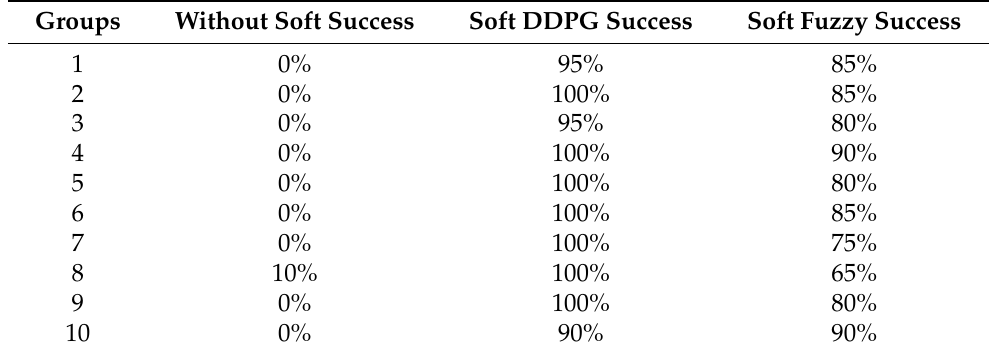
Figure 11. The force variation curve of each experiment. ( a ) Without soft; ( b ) soft with DDPG; ( c ) soft of fuzzy. Table 5. Model test